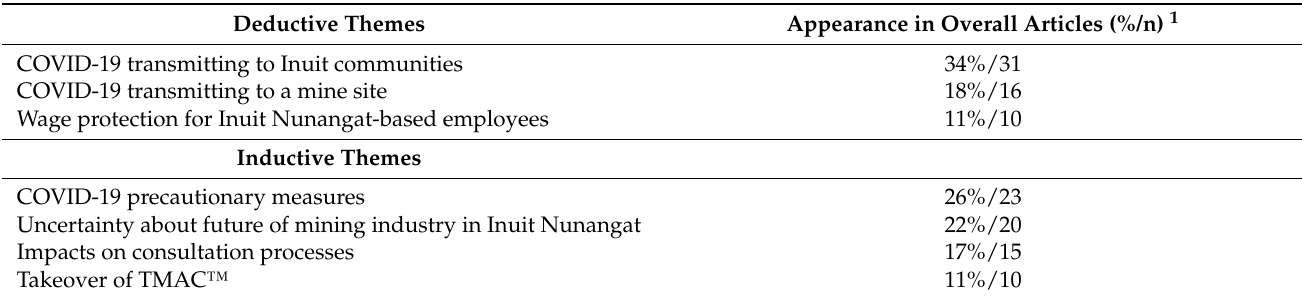
Summary of deductive and inductive themes, by number of appearances, regarding COVID-19 and mining